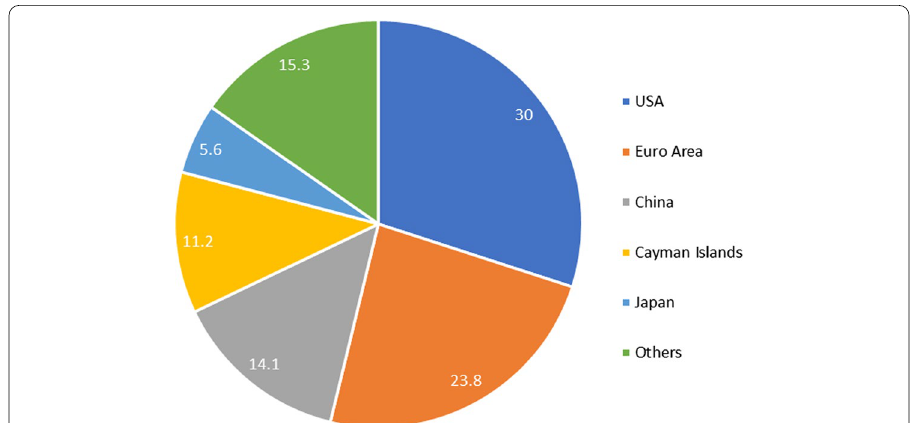
Fig. 2 Share of shadow banking assets by region (%). Source : FSB